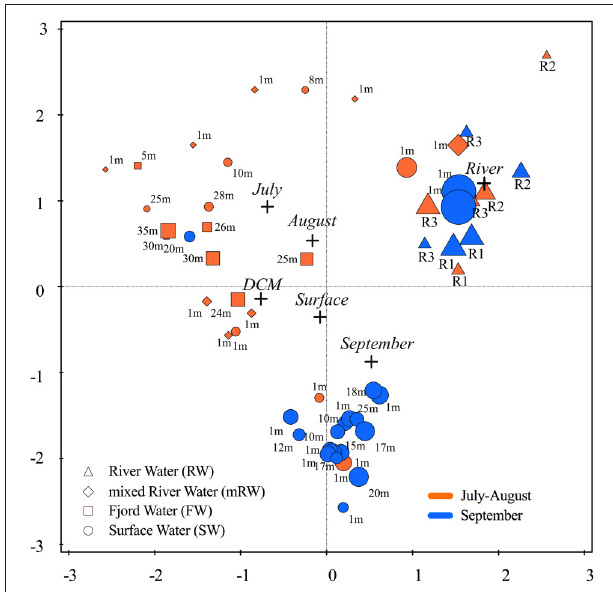
FIGURE 7 | Redundancy analysis biplot summarizing the variation of bacterial diversity based on sequenced 16S rRNA gene fragments at RNA level plotted in relation to nonnumeric explanatory variables (black cross symbol): (1) the month of sampling ( July, August, September ) and (2) sample origin [ River , Surface, and deep chlorophyll max ( DCM )]. The size of the symbols relates to the sample richness at family level. The water type of each sample is given by symbols and the depth of sample collection is added as caption and the period of sampling is indicated by color; the early (orange) and the later (blue) open water